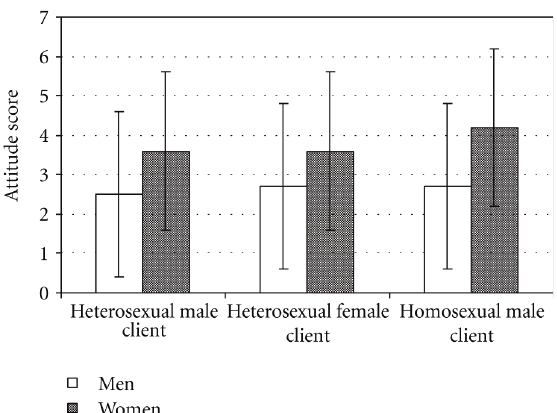
T 2: Interactions of gender with marital status and length of therapy training on attitudes toward cases in the vignette task ( Analysis used